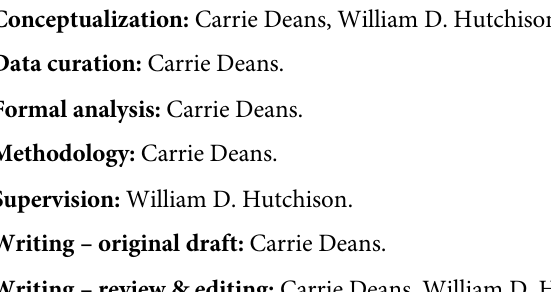
S1 Fig. Time-dependent mortality. Survival curves for male (a-c) and female (d-f) flies from the (a, d) zeta-cypermethrin, (b, e) spinetoram, and (c, f) pyrethrin experiments (N = 10). S1 Table. Survivorship post-hoc results for treatment effects. Tukey’s post-hoc test P-values for the significant treatment effects on survival from the three-way ANOVA. Bolded values indicate statistically significant P-values (P-value � 0.05). S2 Table. Eclosion success post-hoc results for spinetoram. Tukey’s post-hoc test P-values for the significant treatment effects on eclosion success for the spinetoram treatment. Bolded values indicate statistically significant P-values (P-value � 0.05). S3 Table. Treatment � exposure post-hoc results for spinetoram. Tukey’s post-hoc test P-val- ues for the significant treatment � exposure interaction on adult mass for the spinetoram treat- ment. Bolded values indicate statistically significant P-values (P-value � 0.05). S4 Table. Survivorship post-hoc results for pyrethrin. Tukey’s post-hoc test results for the significant sex � treatment interaction on lifespan for the pyrethrin treatment. Bolded values indicate statistically significant P-values (P-value � 0.05). S5 Table. Pupal rate post-hoc results for pyrethrin. Tukey’s post-hoc test P-values for the significant treatment effects on pupal rate for the pyrethrin treatment. Bolded values indicate statistically significant P-values (P-value � 0.05). S6 Table. Treatment � sex interaction post-hoc results for F1 mortality. Tukey’s post-hoc test P-values for the significant parental treatment � sex interaction on F1 mortality for the pyre- thrin treatment. Bolded values indicate statistically significant P-values (P-value � 0.05).